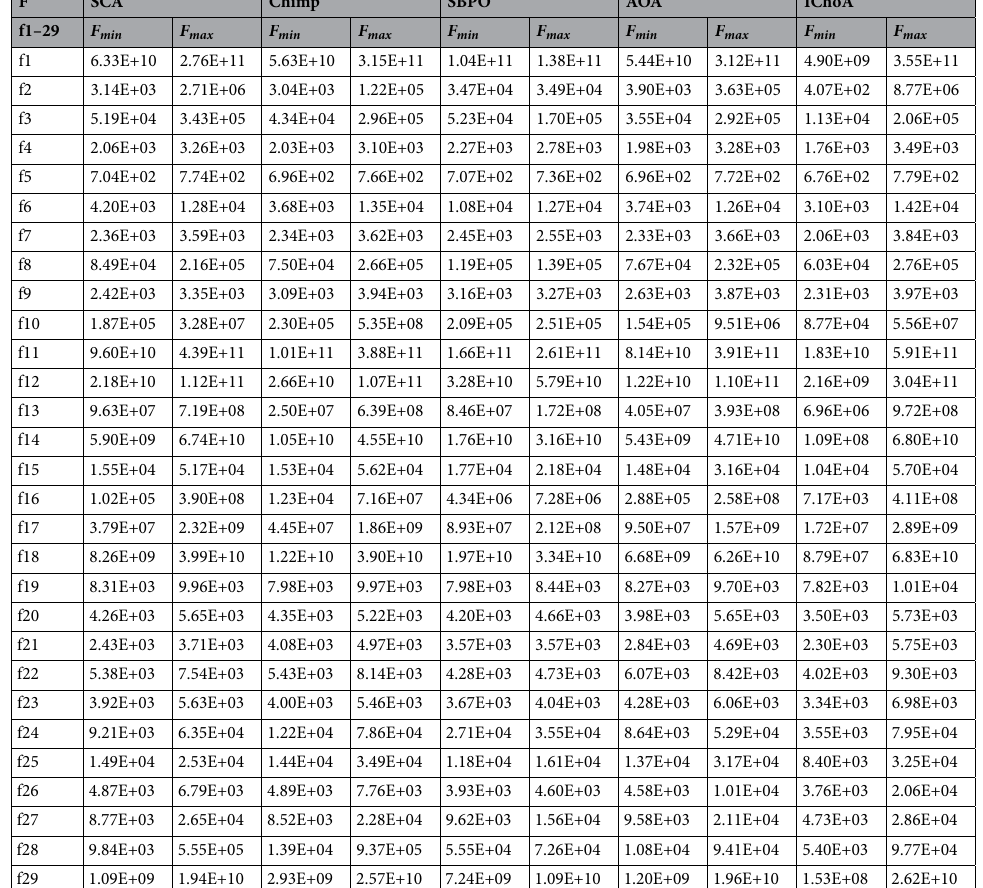
Table 2. The best optima solutions of algorithms on the 29-CEC’2017 standard test